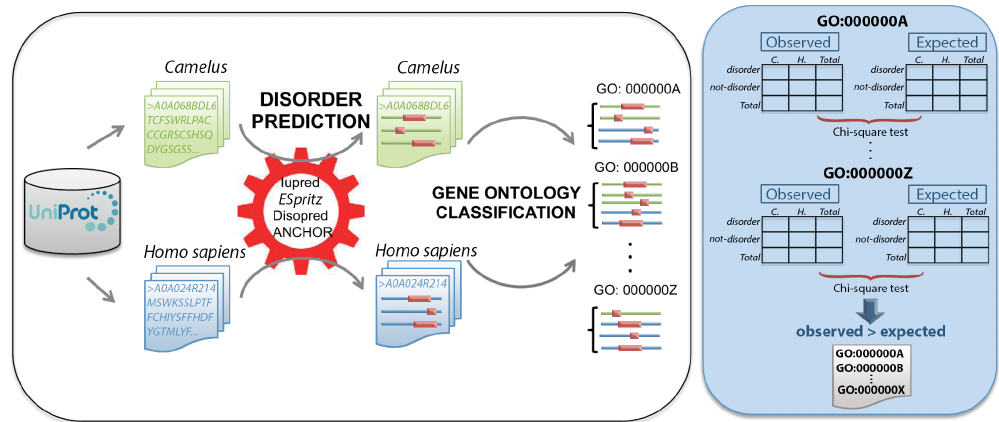
Figure 8. Schematic representation of the methodology used for the comparative study of disordered proteins in Camelus (green) and Homo sapiens (blue). For each organism, protein sequences were retrieved from Uniprot. For each protein, disordered regions (pink) were predicted using three different methods (Iupred, ESpritz, and DISOPRED), and disordered binding regions (DBRs) were predicted using ANCHOR. Disordered proteins were then assigned to GO:BP functional classes using PANZZER, and a comparative analysis of disorder levels between the two genera was performed for each class. Contingency tables were constructed with the per-genus counts of disordered and not-disordered proteins and a Chi-squared test applied. GO classes for which the difference in disorder was positive for Camelus were considered to be more disordered in Camelus than in Homo sapiens